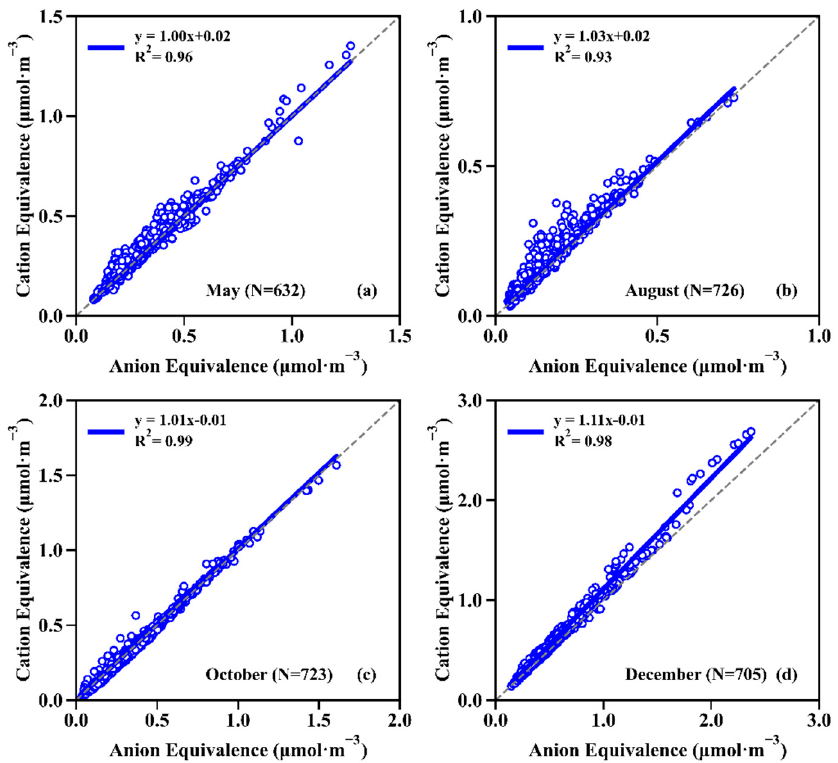
Figure 2. Scatter plots of cations equivalents (CE) versus anions equivalents (AE) in May ( a ), August ( b ), October ( c ) and ( d ) December.